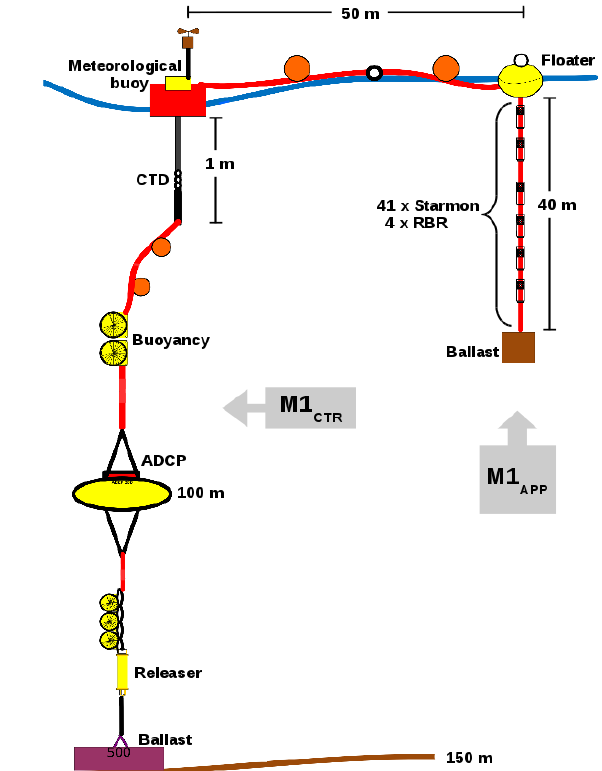
Figure 1. The design drawing of mooring M1. For explanations, see the